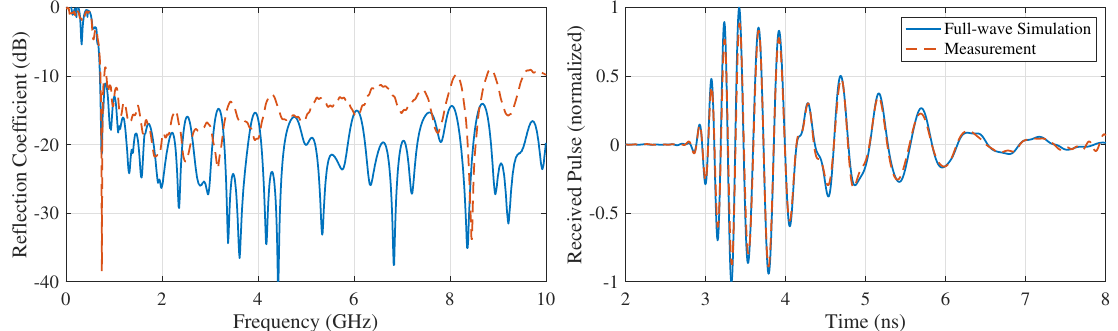
Figure 18. Full-wave simulations of the 16-cell antenna’s phase ( left ) and group delay ( right ) due to dispersion both with and without the inclusion of a substrate. Note that phase unwrapping starts at 10 GHz.